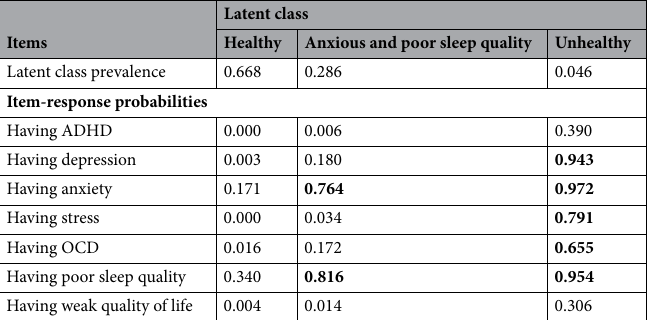
Predictors P-value Healthy